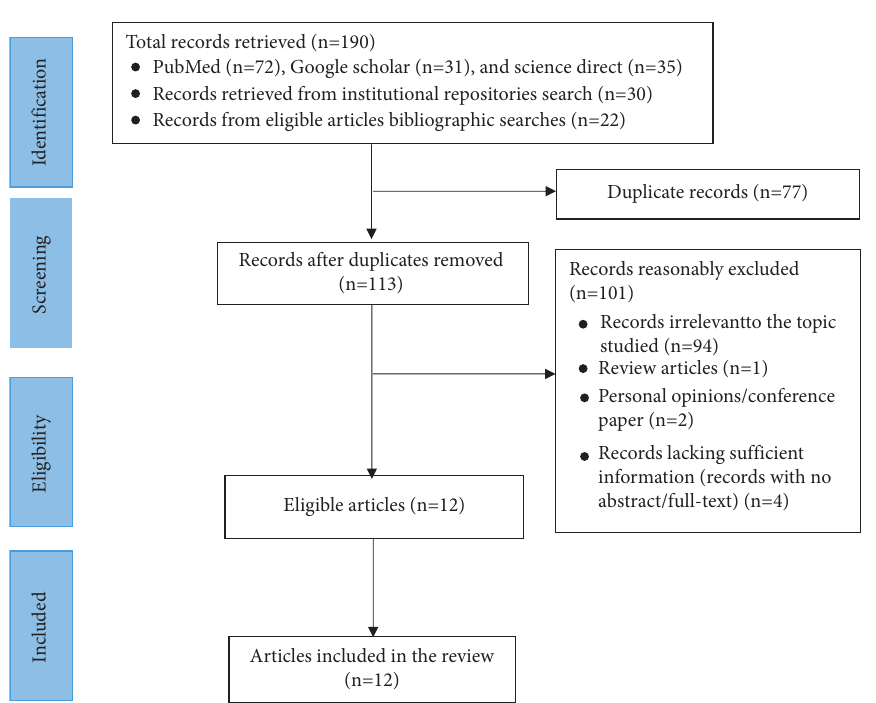
Figure 1: PRISMA flow chart showing studies retrieved, screened, and